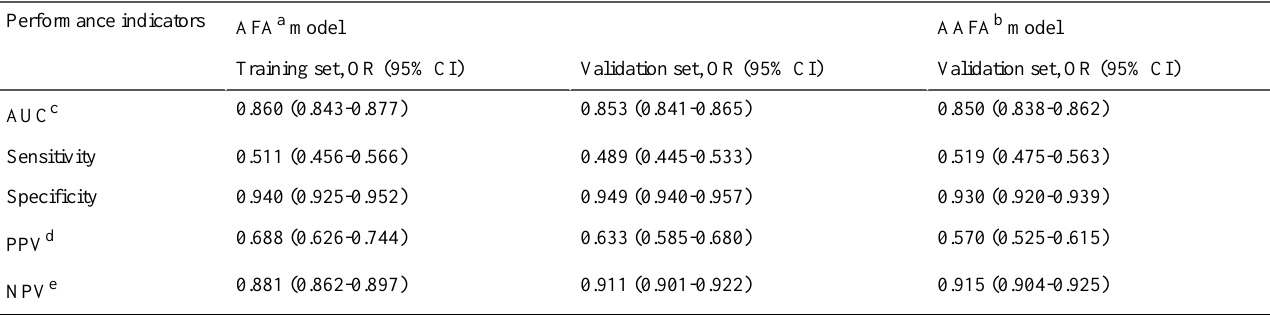
Table 4. The performance of AFA